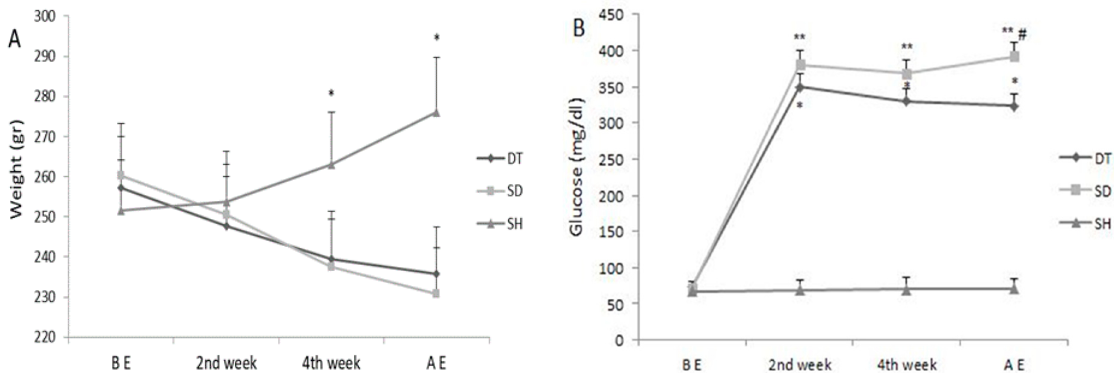
Figure 1. ( A ) Weight change during and after ET. *; Significant difference between the SH group with DT and SD groups in 4th week and AE. ( B ) Changes in the serum levels of glucose during six weeks ET period. *; significant difference ( p < 0.001) between DT and SH groups in 2nd week, 4th week, and AE with SH group.**; significant difference ( p < 0.001) between SD and SH groups in 2nd week, 4th week, and AE with SH group # ; significant difference ( p < 0.001) between DT and SD